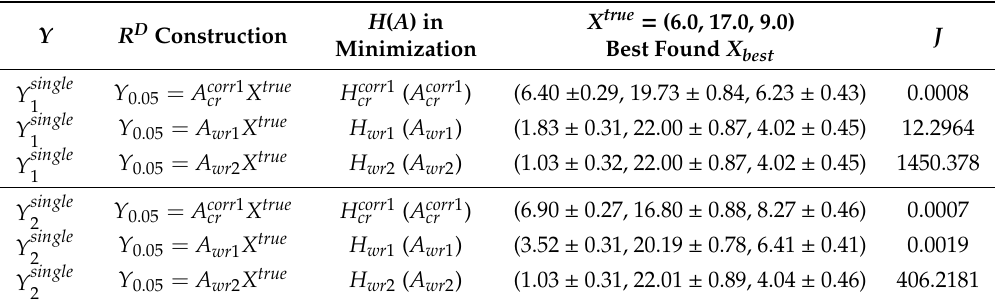
(or Y single ) denotes data from single measured 2 1